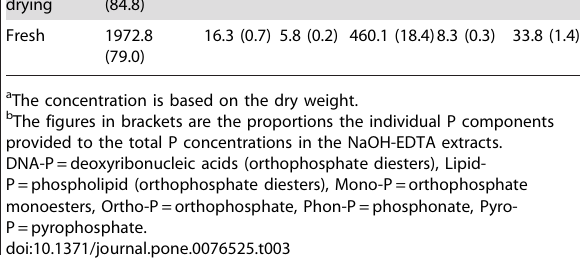
Table 2. Concentrations { ` of total P (TP), organic P (Po), and metals in the NaOH-EDTA extract after different pre-treatments.